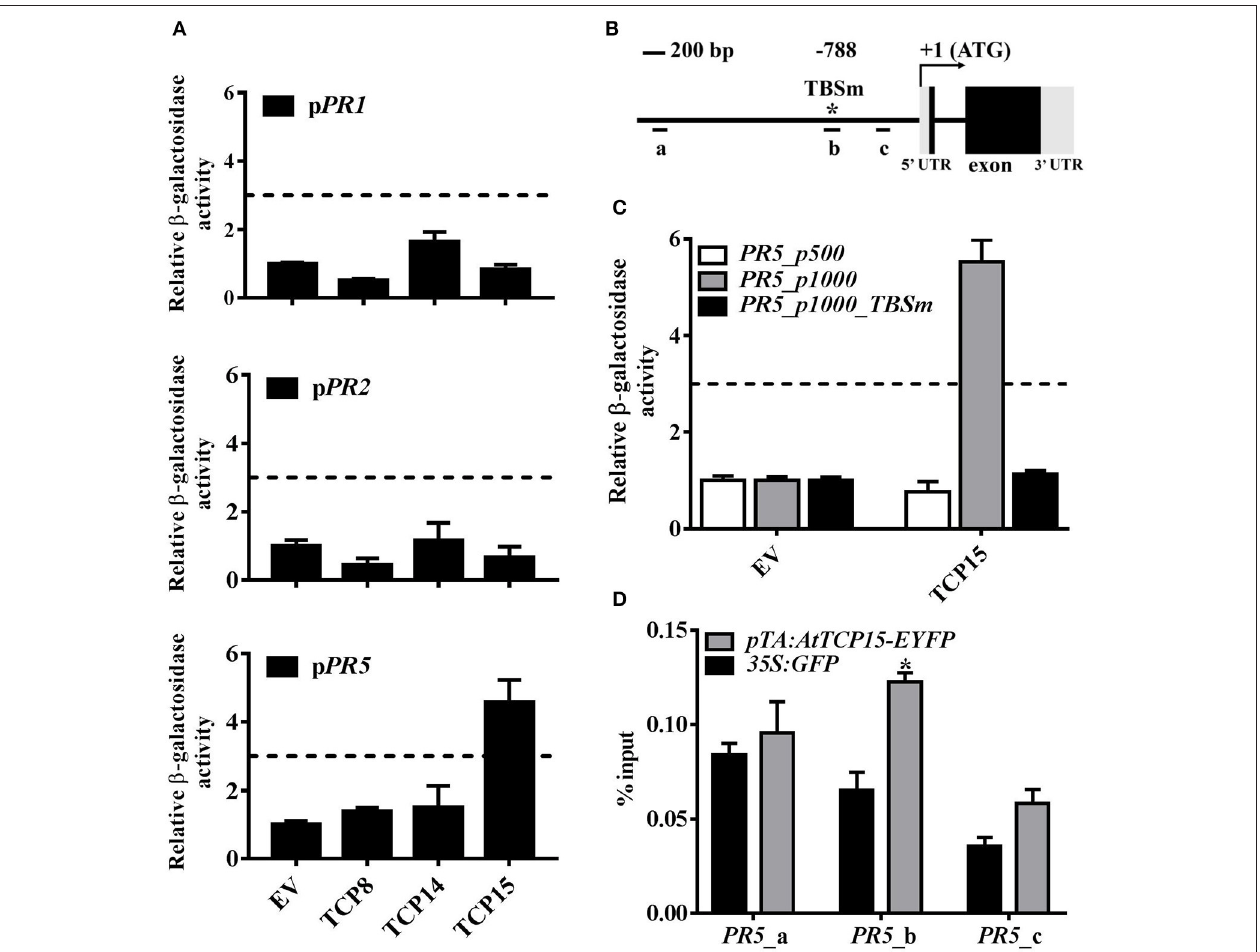
FIGURE 3 | TCP15 binds to the PR5 promoter at the TCP binding site. (A) Interactions between the TCP transcription factors and the PR promoters in yeast one-hybrid system (Y1H). Constructs expressing pDEST22-TCPs and empty pDEST22 (EV) were transformed into the yeast strain YU. The PR promoters fused with LacZ reporter gene were integrated into the yeast strain YM4271. Healthy diploids grew on dropout medium without tryptophan and uracil were selected. Binding ability between TCPs and the PR promoters was quantified by β -galactosidase activity which was calculated in fold change over EV control. Three-fold induction was set as the cut-off. The binding ability of TCP8, TCP14, and TCP15 to the PR1 promoter (upper panel), the PR2 promoter (middle panel), and the PR5 promoter (lower panel) is shown. Error bars represent SD of three repeats. (B) Diagram of the PR5 gene structure. ( + 1) means transcription start site; long line indicates the promoter of PR5 ; short lines marked by a, b, and c represent the fragments amplified by RT-PCR in (D) ; star shows TCP binding site located at − 788 bp; TCPm represents TCP binding site with mutations. (C) Interactions between TCP15 with the PR5 promoter containing a TCPm and the PR5 promoter (500 bp) in Y1H assays. Error bars represent SD of three repeats. (D) Association between TCP15 and the PR5 promoter was studied by chromatin immunoprecipitation (ChIP) assays combined with RT-PCR analysis. Twelve-day-old seedlings of pTA:AtTCP15-EYFP and 35S:GFP transgenic plants were treated with 30 µ M DEX for 24h. Samples were collected at another 24h after 0.5mM SA induction. The enrichment of PR5 promoter DNA in immunoprecipitated samples was shown as % input. Error bars represent SD of three technical repeats. Statistical analysis was studied by t -test (* p < 0.05) using Excel 2016. Another independent repeat showed similar